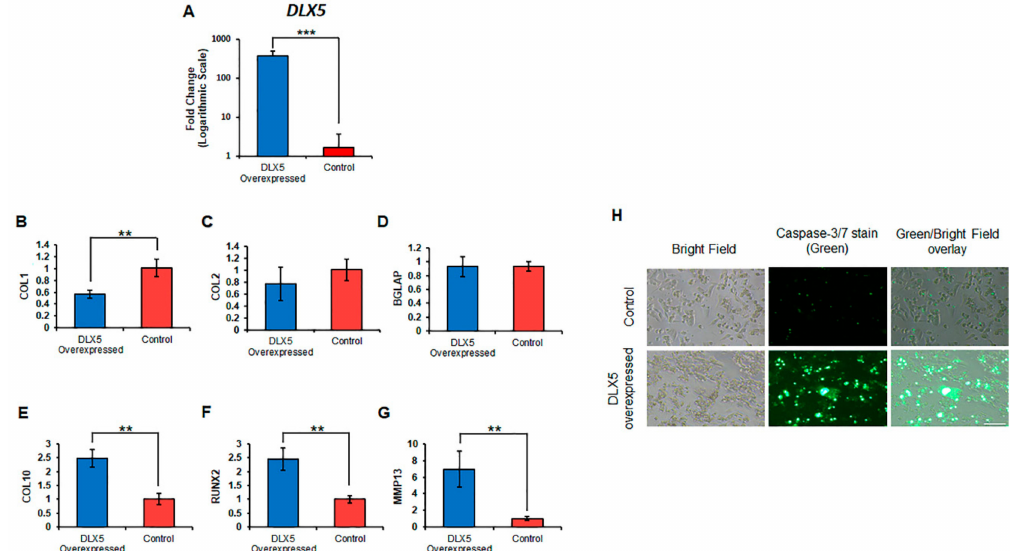
Figure 5. Overexpression of DLX5 in C-PCs stimulate hypertrophy, ossification, catabolism markers and increases apoptosis. ( A ) Relative mRNA expression levels of DLX5 gene, chondrogenic markers ( B ) COL1, ( C ) COL2 as well as hypertrophy and ossification-related markers ( D ) BGLAP, ( E ) COL10, ( F ) RUNX2, and catabolic proteinase ( G ) MMP13 in DLX5 overexpressed C-PCs vs. control C-PCs. N ≥ 3; **, p ≤ 0.01; ***, p ≤ 0.005 relative to control C-PCs. ( H ) Caspase-3 / 7 immunofluorescent staining of DLX5 overexpressed C-PCs vs. control C-PCs. Scale = 250 µ